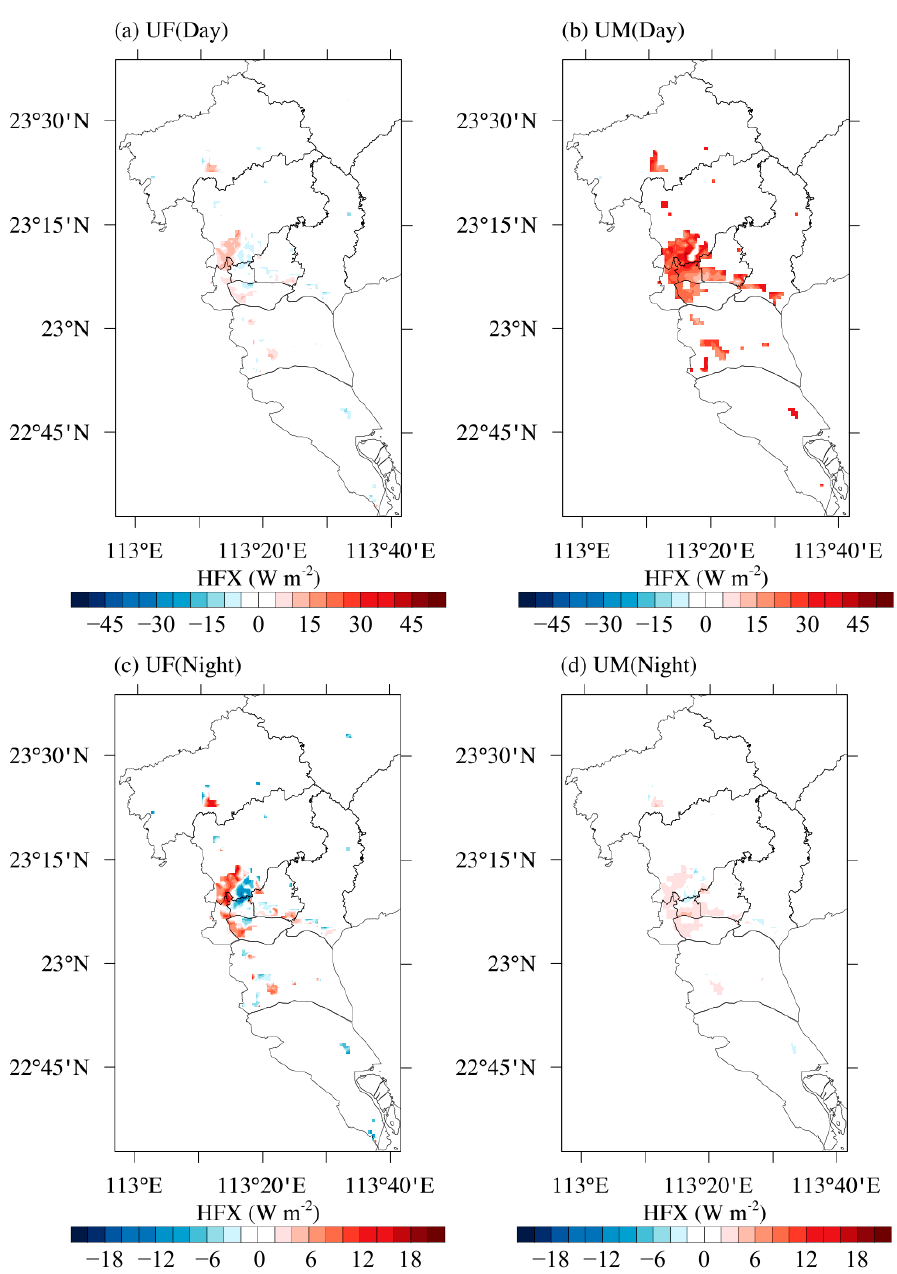
Figure 7. Effects of high-resolution UF and UM on the daytime and night-time sensible heat fluxes (HFX) in the underlying urban surface of the Guangzhou metropolitan area. Here, the impacts of UF/UM during daytime were calculated by comparing the simulated hourly HFX values from 08:00 LST to 16:00 LST for 10 days (from 1 to 10 November) in two experiments and then averaging the result. Meanwhile, those during night-time were derived using the data from 17:00 LST to 07:00 LST. ( a , c ) Effect of UF (Case 1—Base); ( b , d ) effect of UM (Case 2—Base).